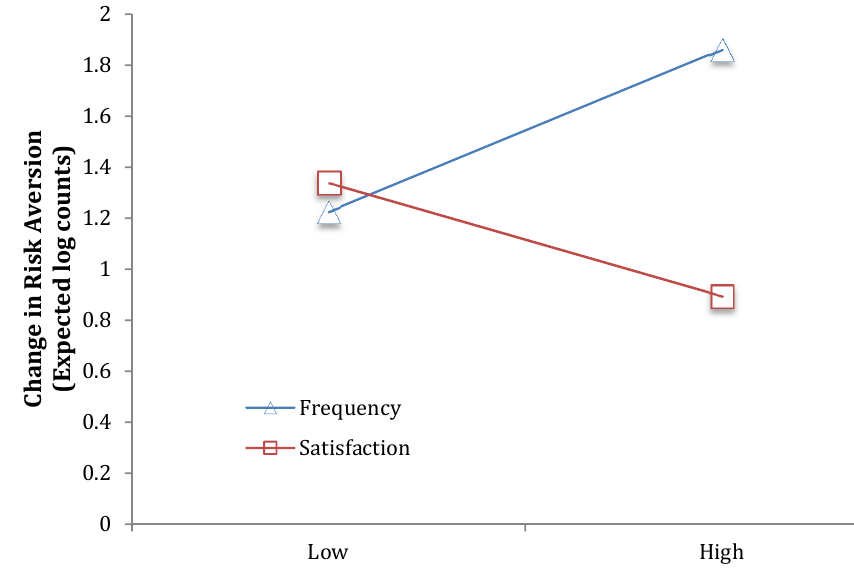
Figure 2. Cross-over effect of Satisfaction and Frequency .